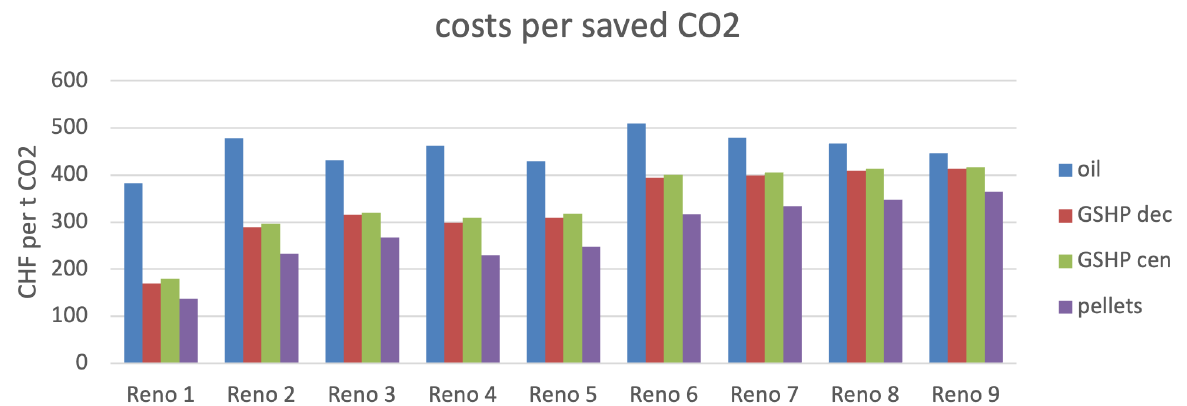
Figure 3. Economic evaluation of the renovation options with different supply